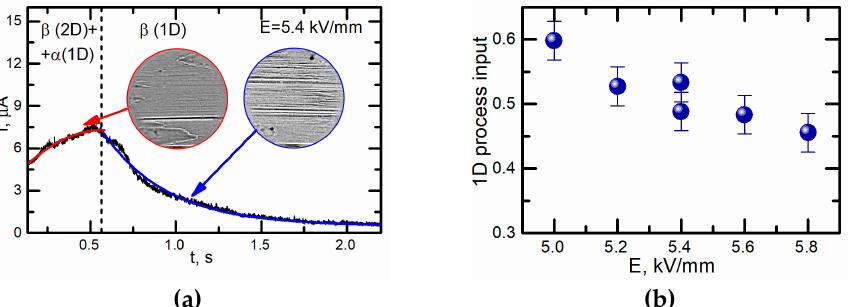
Figure 7. ( a ) The switching current for 5.4 kV/mm fitted by Equation (2). ( b ) The field dependence of the input of the 1D switching process to the polarization reversal.